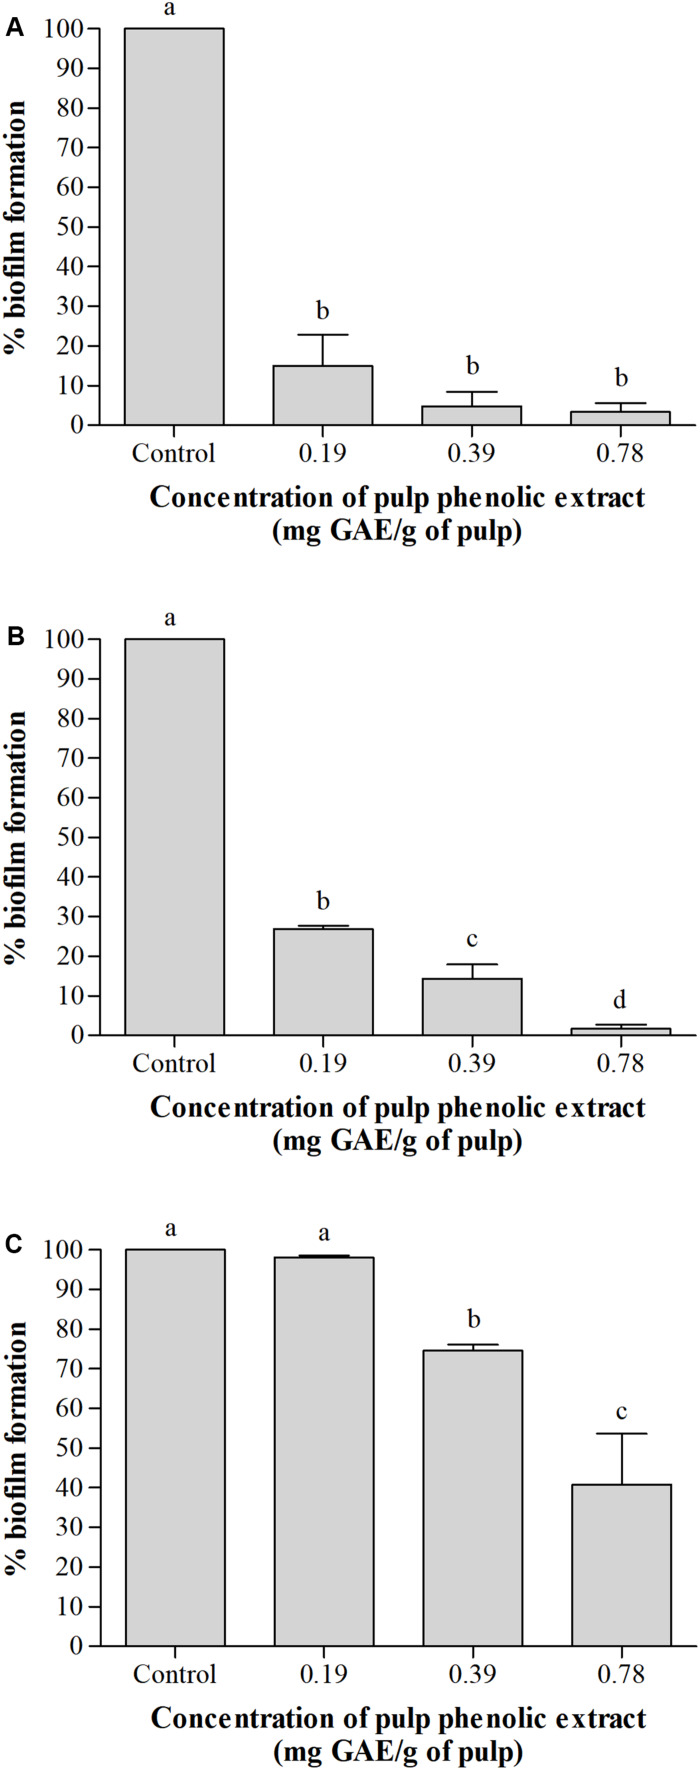
Percentage (%) of biofilm formation by A. hydrophila
(A), E. coli
(B), and S. marcescens
(C) in absence and presence of pulp phenolic extract of S. cumini (L.) Skeels at sub-MIC of 0.19, 0.39, and 0.78 mg GAE/g of pulp. Means followed by different letters differ statistically (p < 0.05).